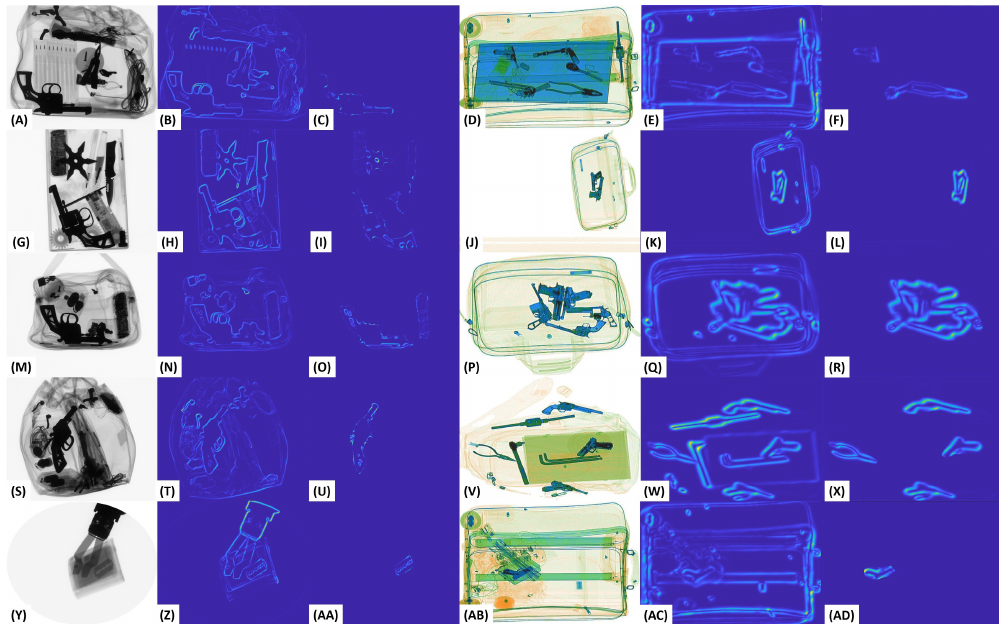
Figure 7. Irrelevant edge suppression through the proposed meta-transfer learning-driven tensor-shot detection framework are shown in (( A )–( AD )). Also, the first and fourth column show the original